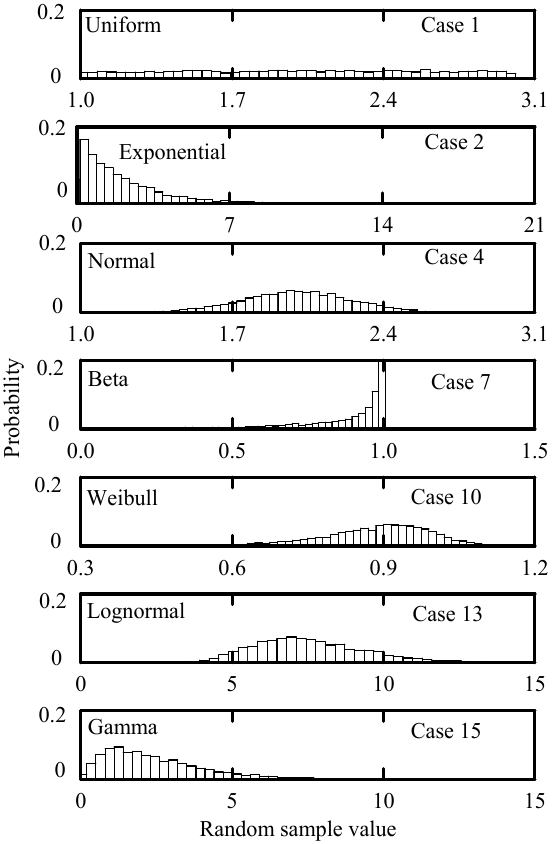
Figure 2. Seven typical probability distributions. Case n ( n = 1, 2, 4, 7, 13, and 15) corresponds to the case in Table 1.